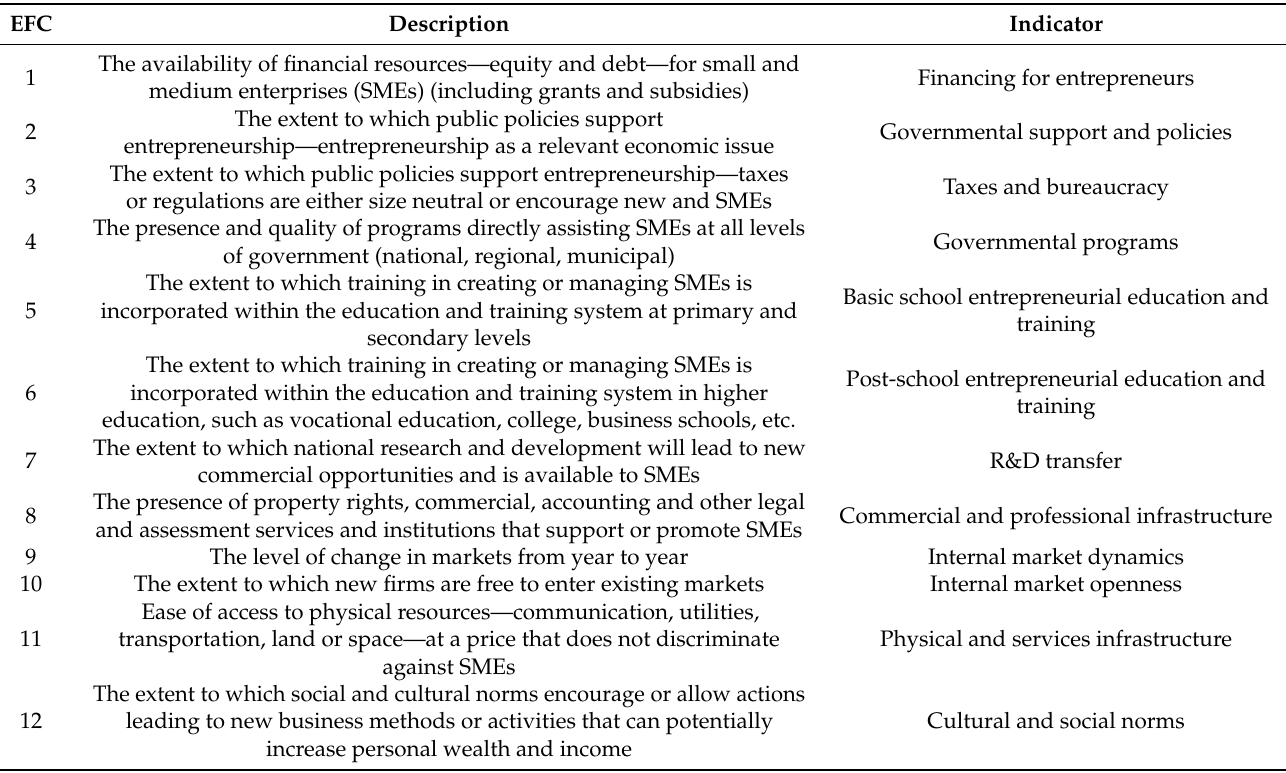
Table A1. Description of Entrepreneurial Framework Conditions (EFCs). Source: